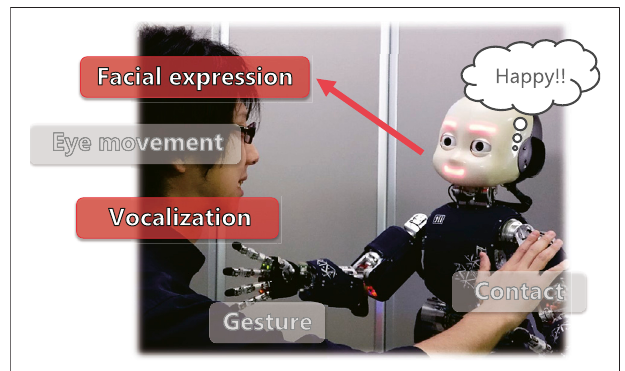
FIGURE 1 | Action selection during multimodal affective interaction between a human and